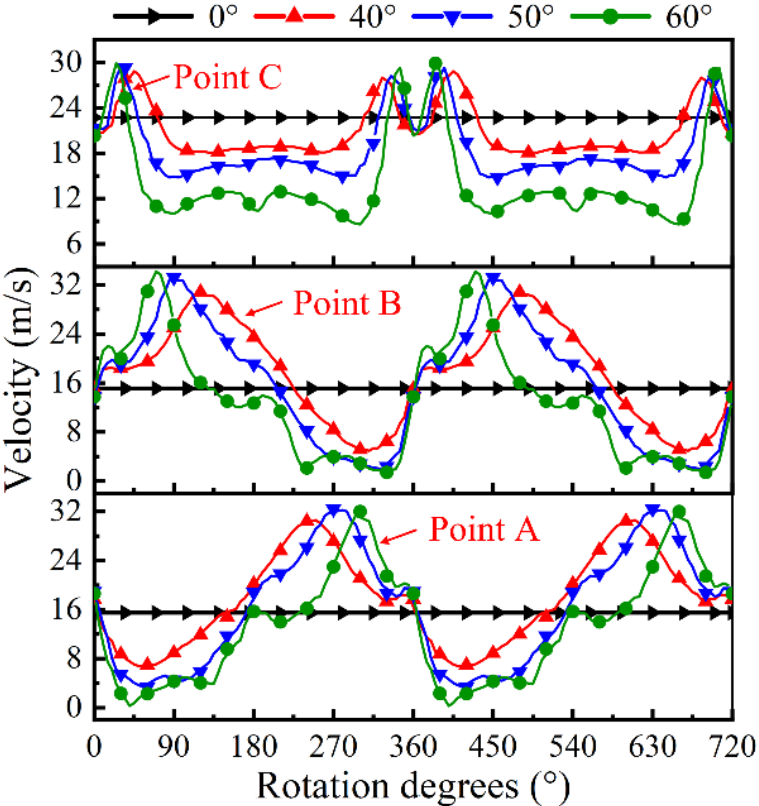
Figure 5. The variation of electrolyte velocity on points A to C in the IEG under kinds of tube tools.